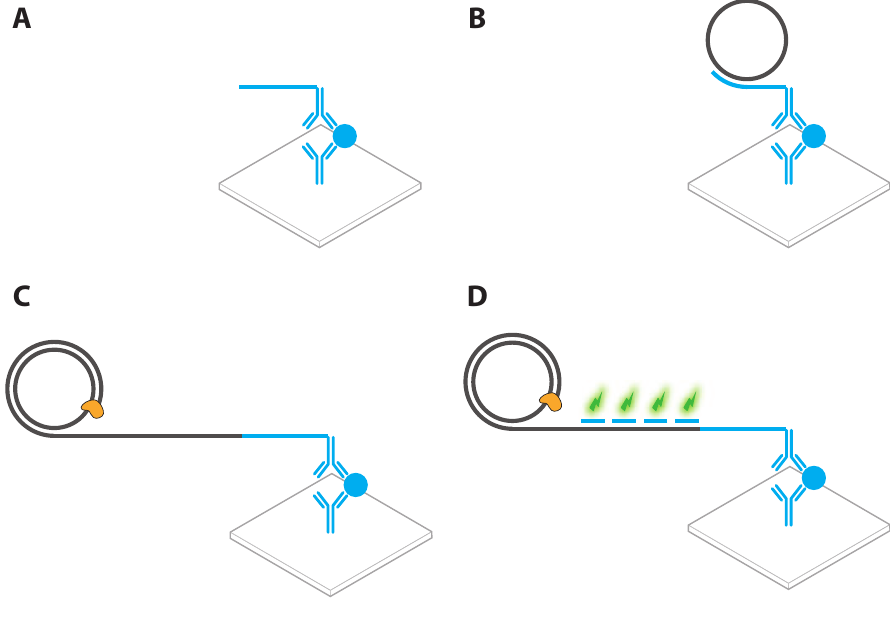
Figure 9. Schematic overview of the immuno-RCA assay. ( A ) DNA labeled antibodies are used in an otherwise standard sandwich immuno assay. ( B ) Hybridization of a circular DNA probe ( C ) RCA. ( D ) The amplified product is labeled through hybridization with fluorescently labeled oligonucleotides, leading to significant signal